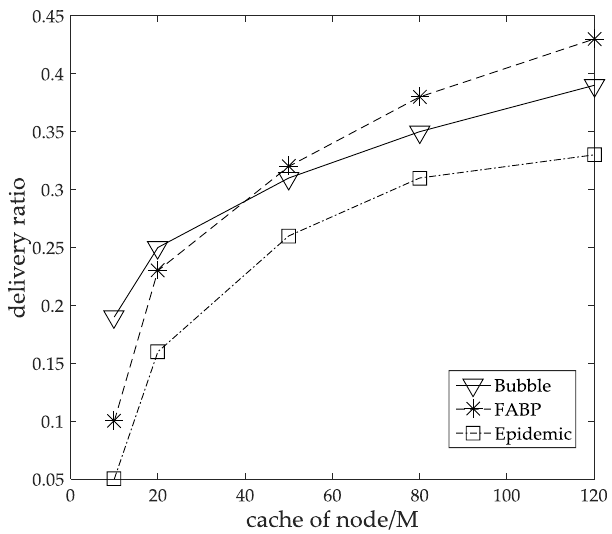
Figure 8. Comparison of the delivery ratio under different caches.